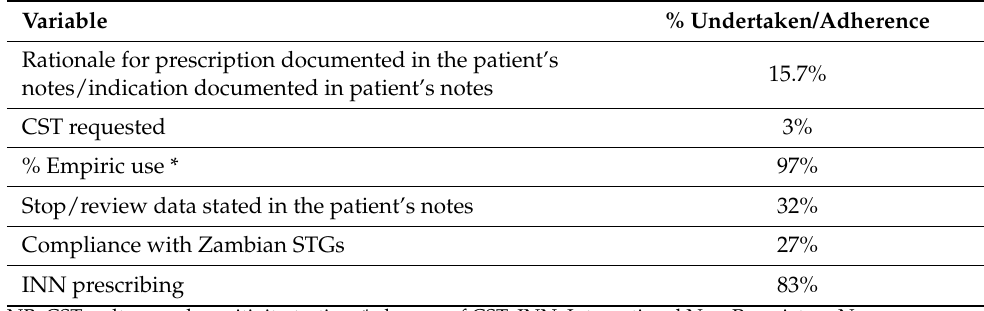
Table 3. Quality indicator measures for antibiotics prescribed ( n =